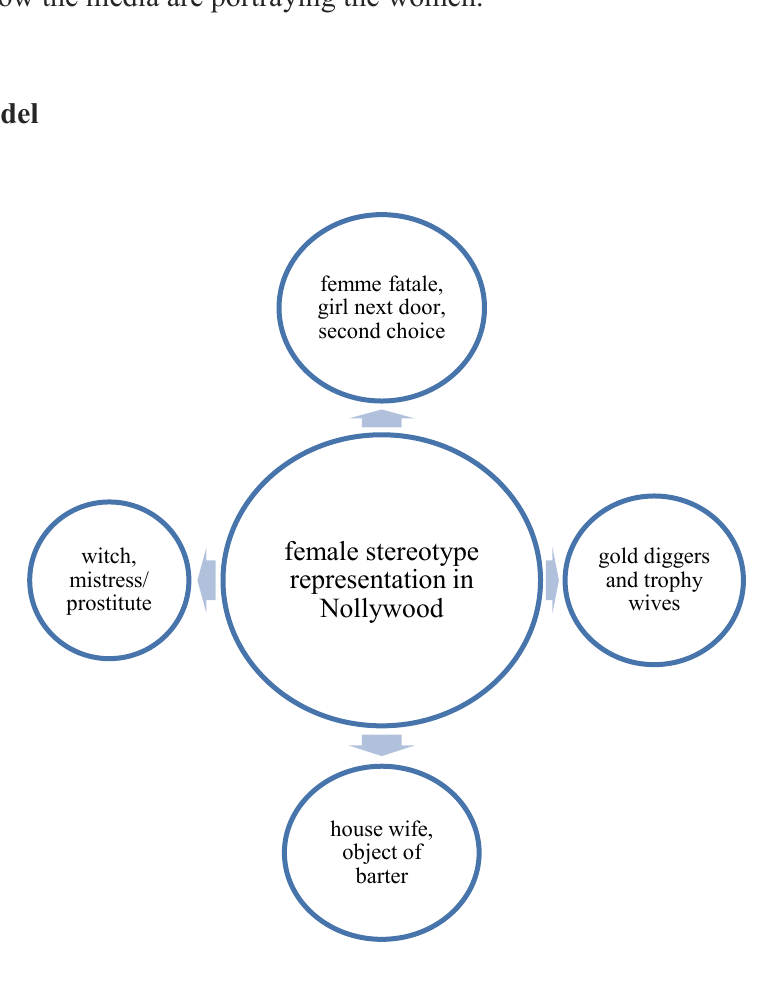
Fig 1: Conceptual framework of female stereotype representation in Nigerian films Source: (Ibbi,